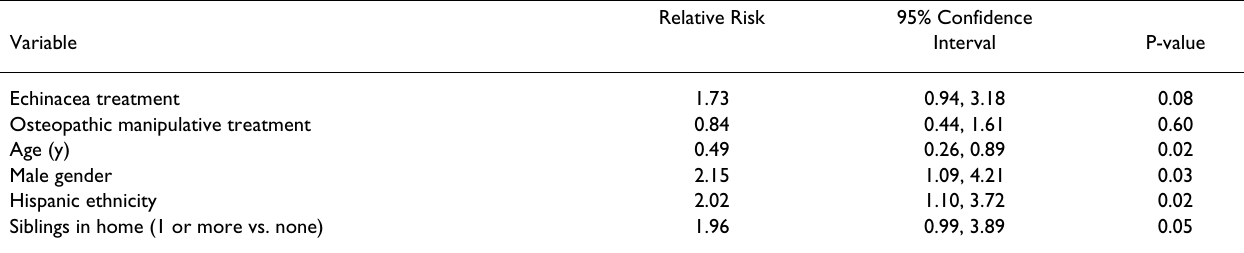
Relative Risk 95% Confidence